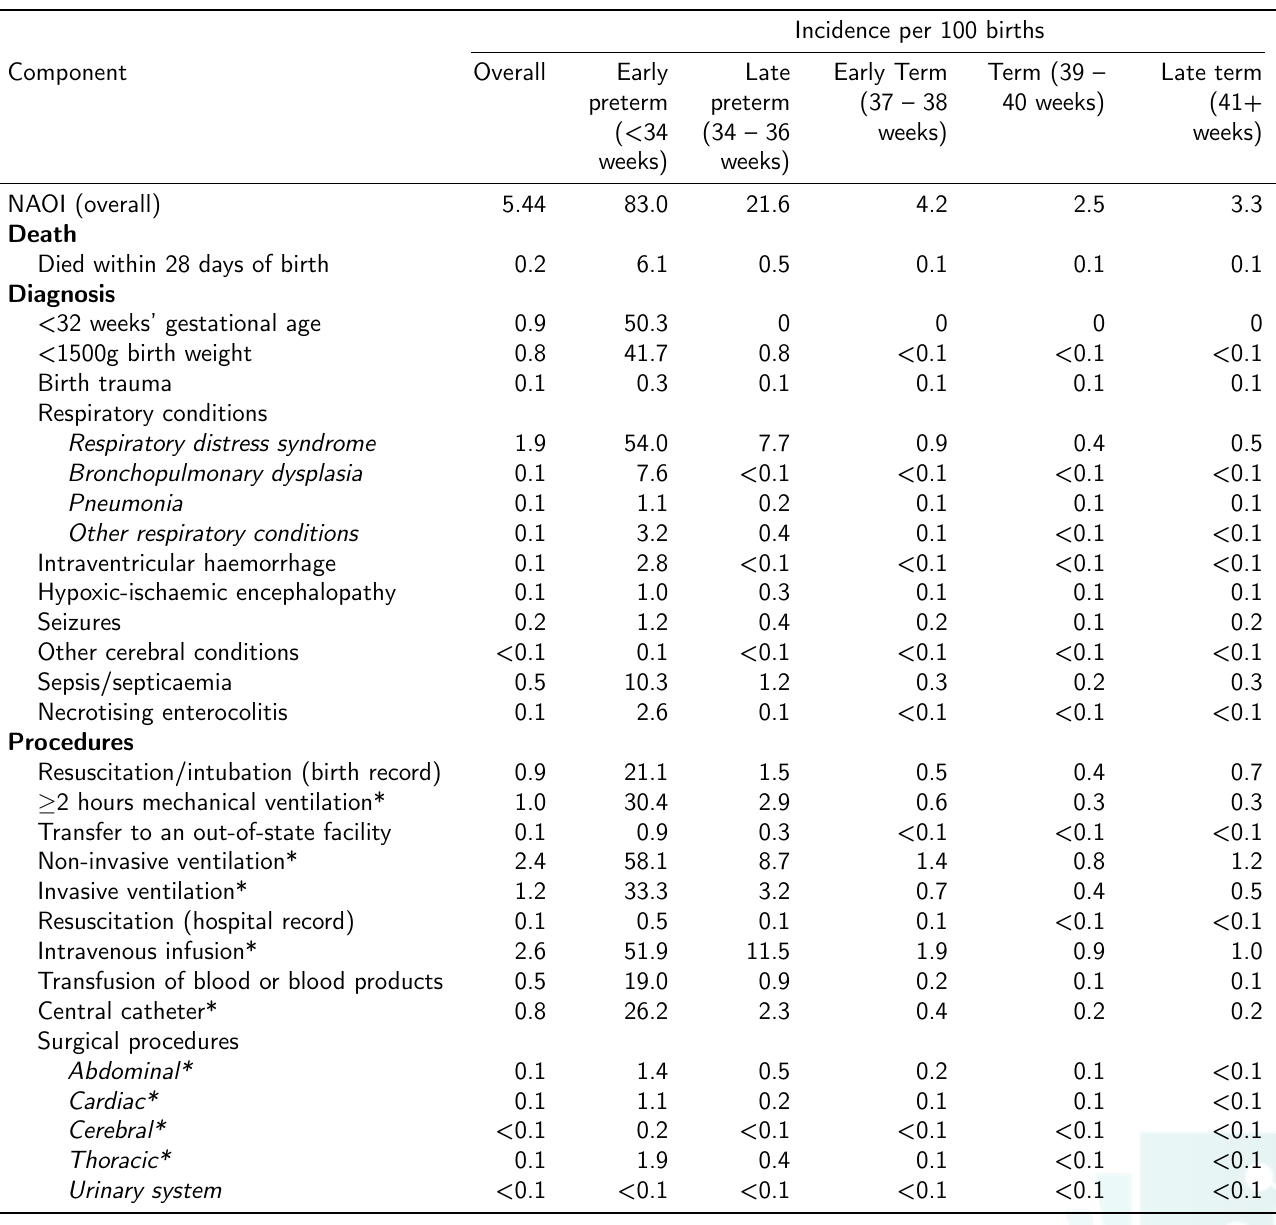
Supplementary Table 1. Incidence per 100 births for the neonatal adverse outcome indicator (NAOI) and components, by gestational age term